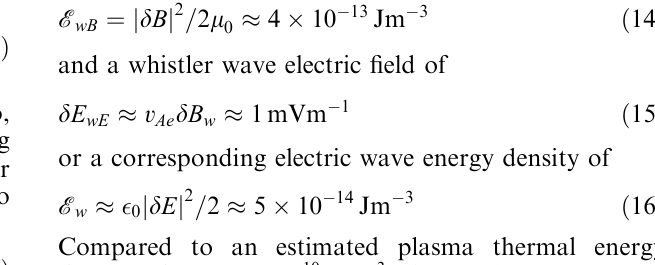
Fig. 8. Whistler growth rates in an anisotropic electron plasma as function of the temperature anisotropy A e (cid:135) 1 and electron beta b (after Gary, 1993). For the measured weak anisotropy A e (cid:136) 0 : 1 and 1 < b < 10 the growth rate is of the order of the ion cyclotron e frequency c (cid:25) x ci . The curves are drawn for f pe = f ce (cid:136) 100, close to that expected in